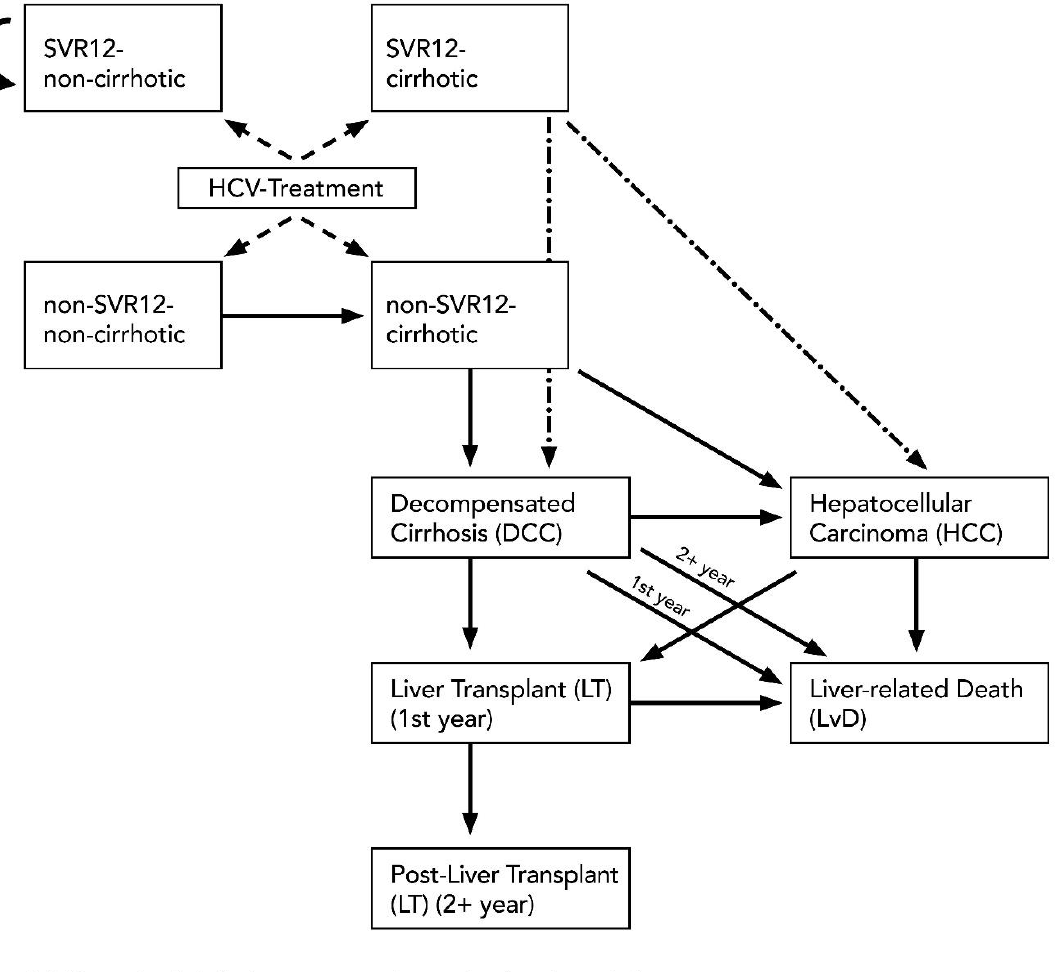
Figure 1. Markov modelling for cost-effectiveness analysis.